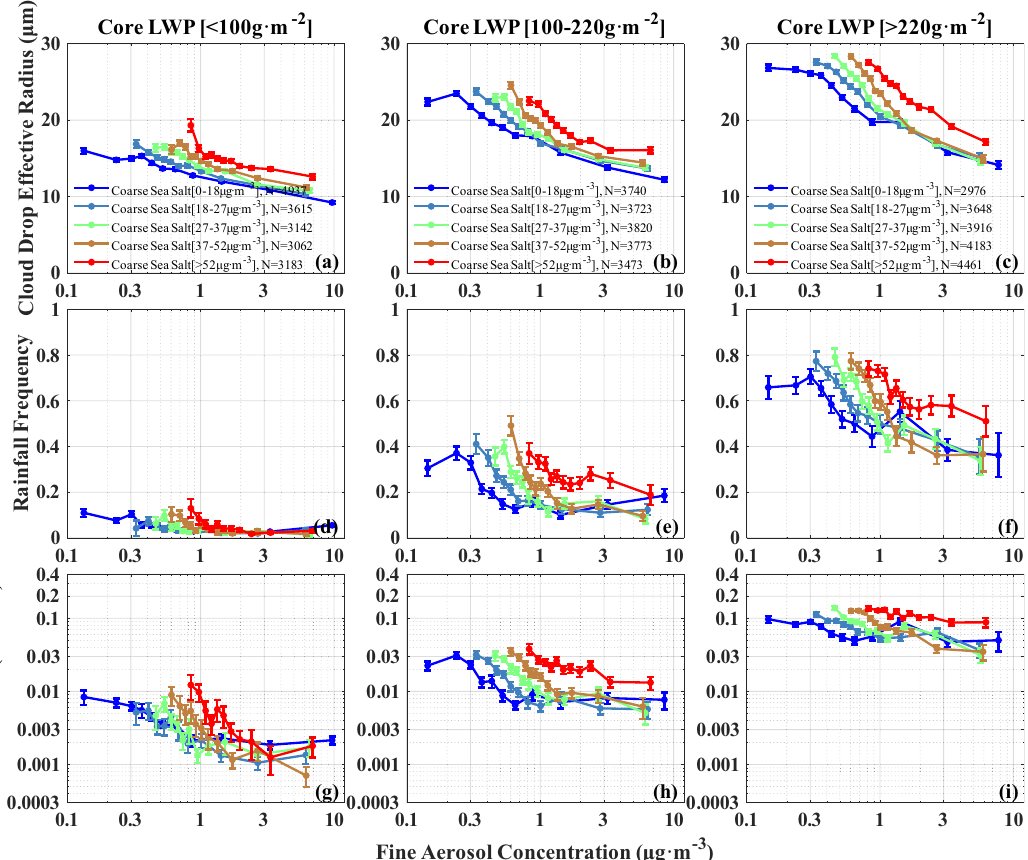
Fig. 4 Aerosol-driven cloud drop effective radius ( r e ) and rainfall variations of warm clouds for fi ne aerosol concentration under different constant intervals of coarse sea spray aerosols (CSA) concentration and cloud liquid water path (LWP). The three columns represent low, moderate, and high cloud liquid water path, respectively. Shown are r e ( a – c ), rainfall frequency ( d – f ), and g – i rainfall fl ux (including both rainfall and non-rainfall cases). The color lines connect the dots, which are the averaged r e , rainfall frequency and fl ux at eleven bins of fi ne aerosol concentrations, including the 0 – 5%, 5 –